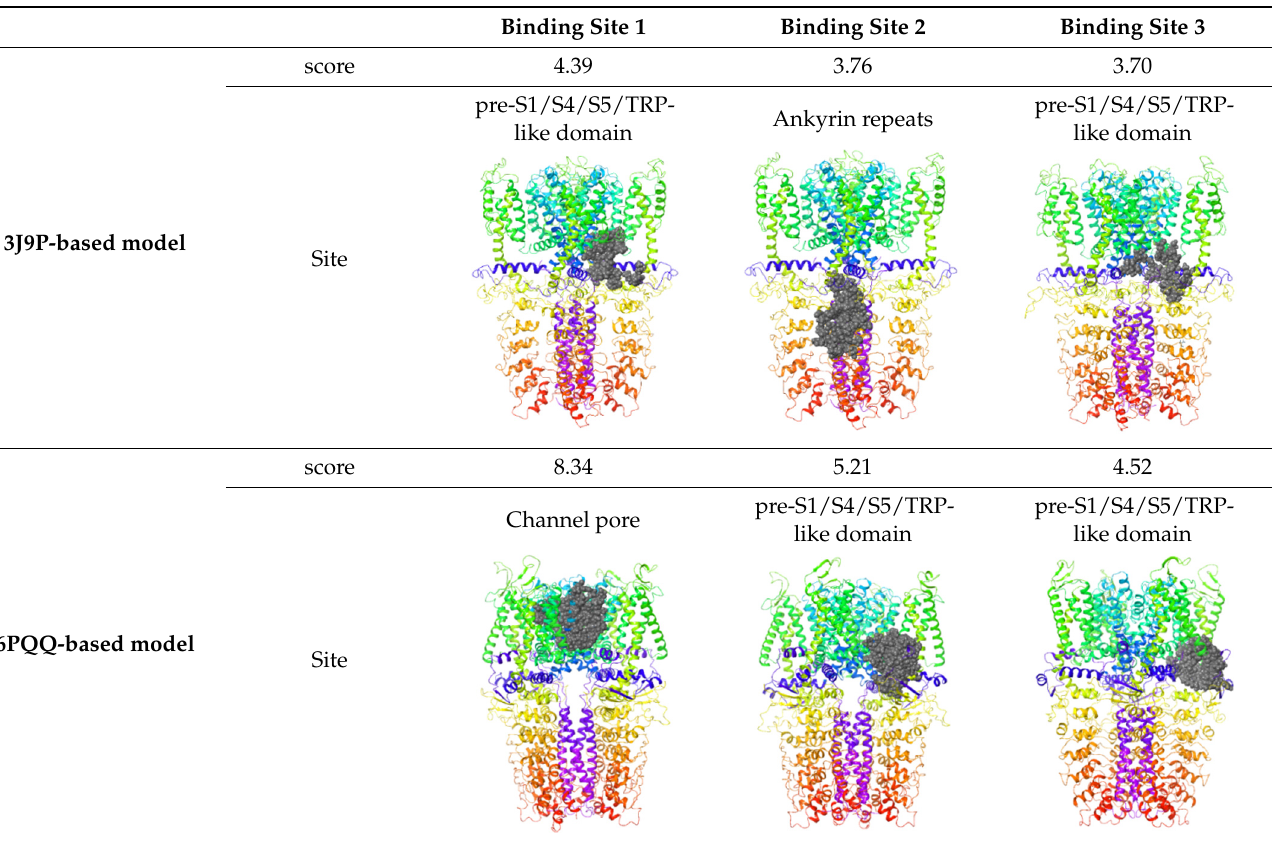
Table 3. MetaPocket2.0 binding site prediction results for models based on 3J9P and 6PQQ: graphical illustration and evaluation score.